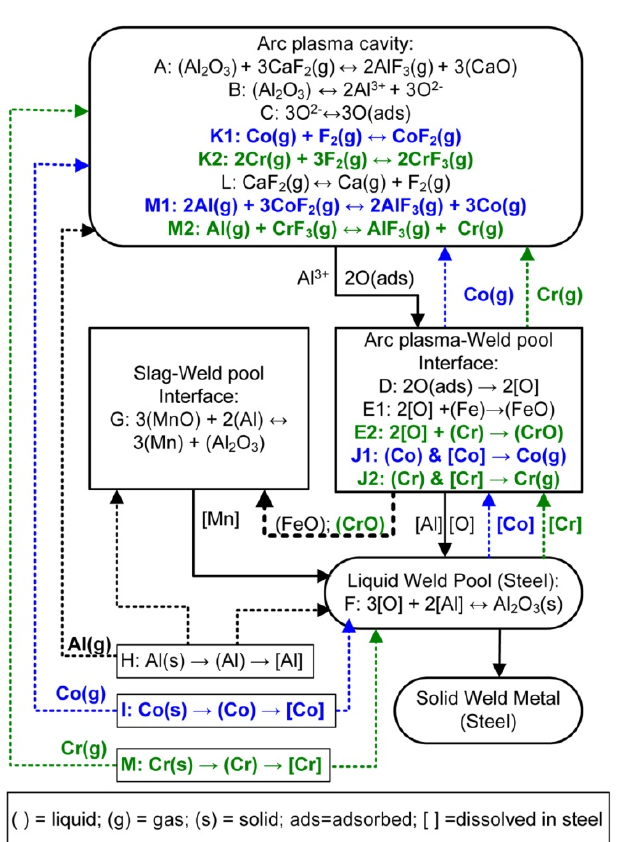
Figure 11. SAW reaction flow diagram with Al, Co and Cr powder additions.